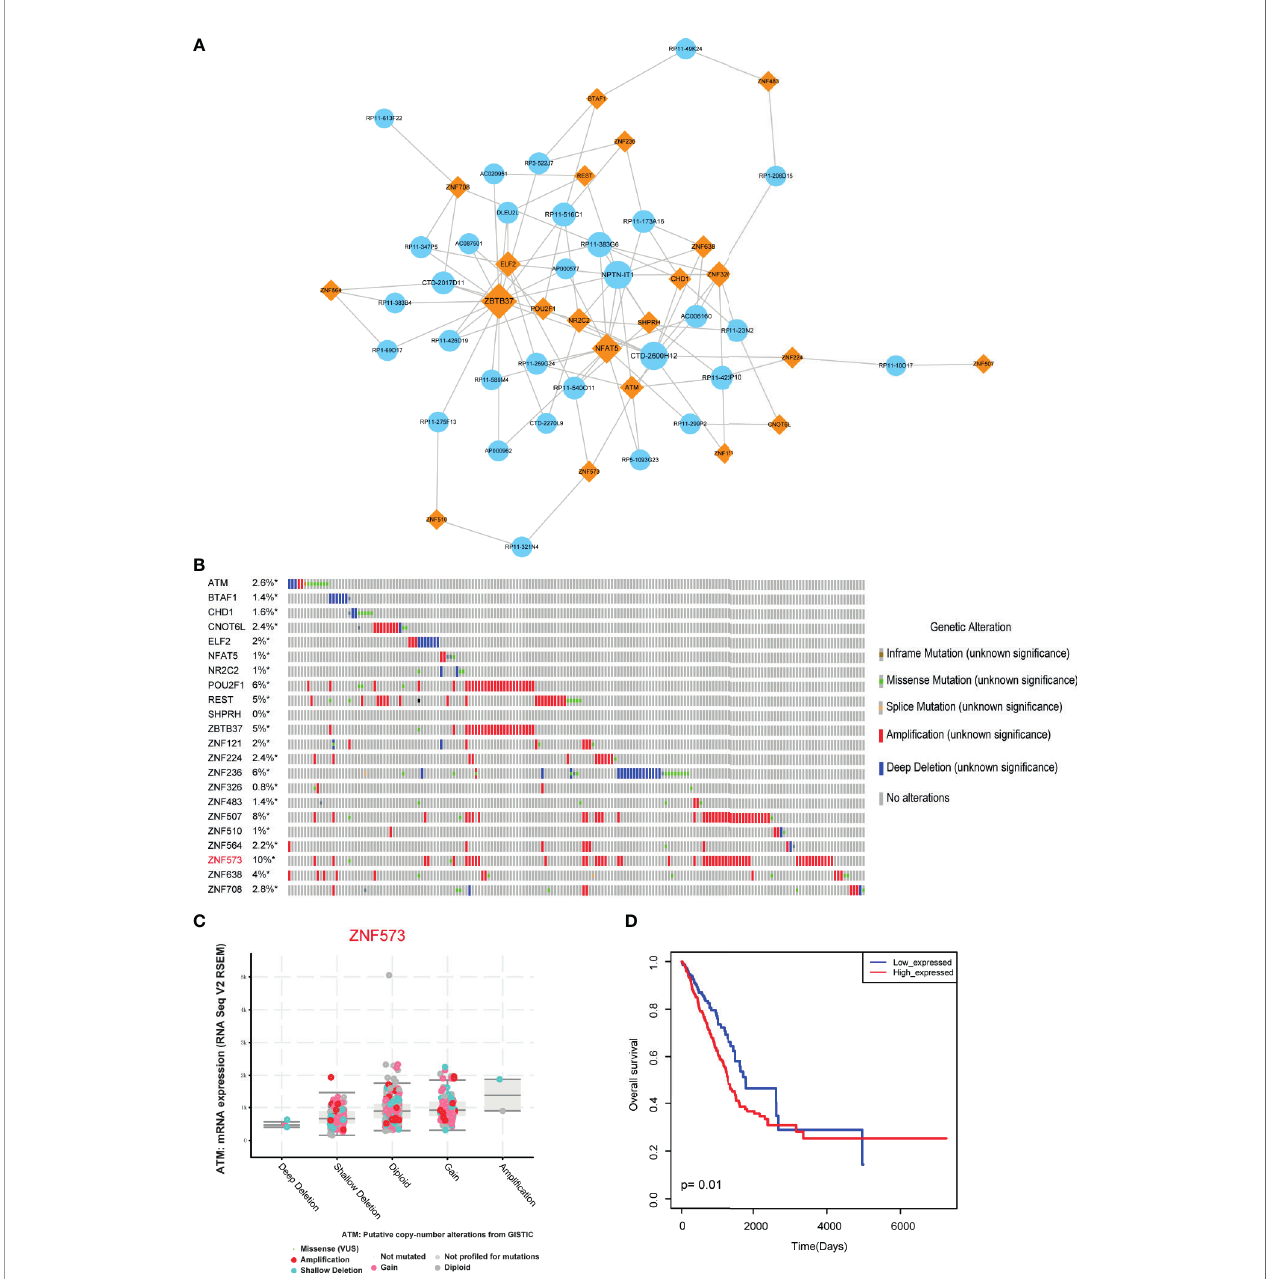
FIGURE 4 | Module analysis of LUAD-related lncRNA-TF network. (A) Cytoscape visualization of module in LUAD-related lncRNA-TF network. (B) Genetic alteration information of TFs in modules. (C) Genetic alteration has impact on TF expression. (D) The prognosis effects of the lncRNA-related module. *represents genes were selected in the